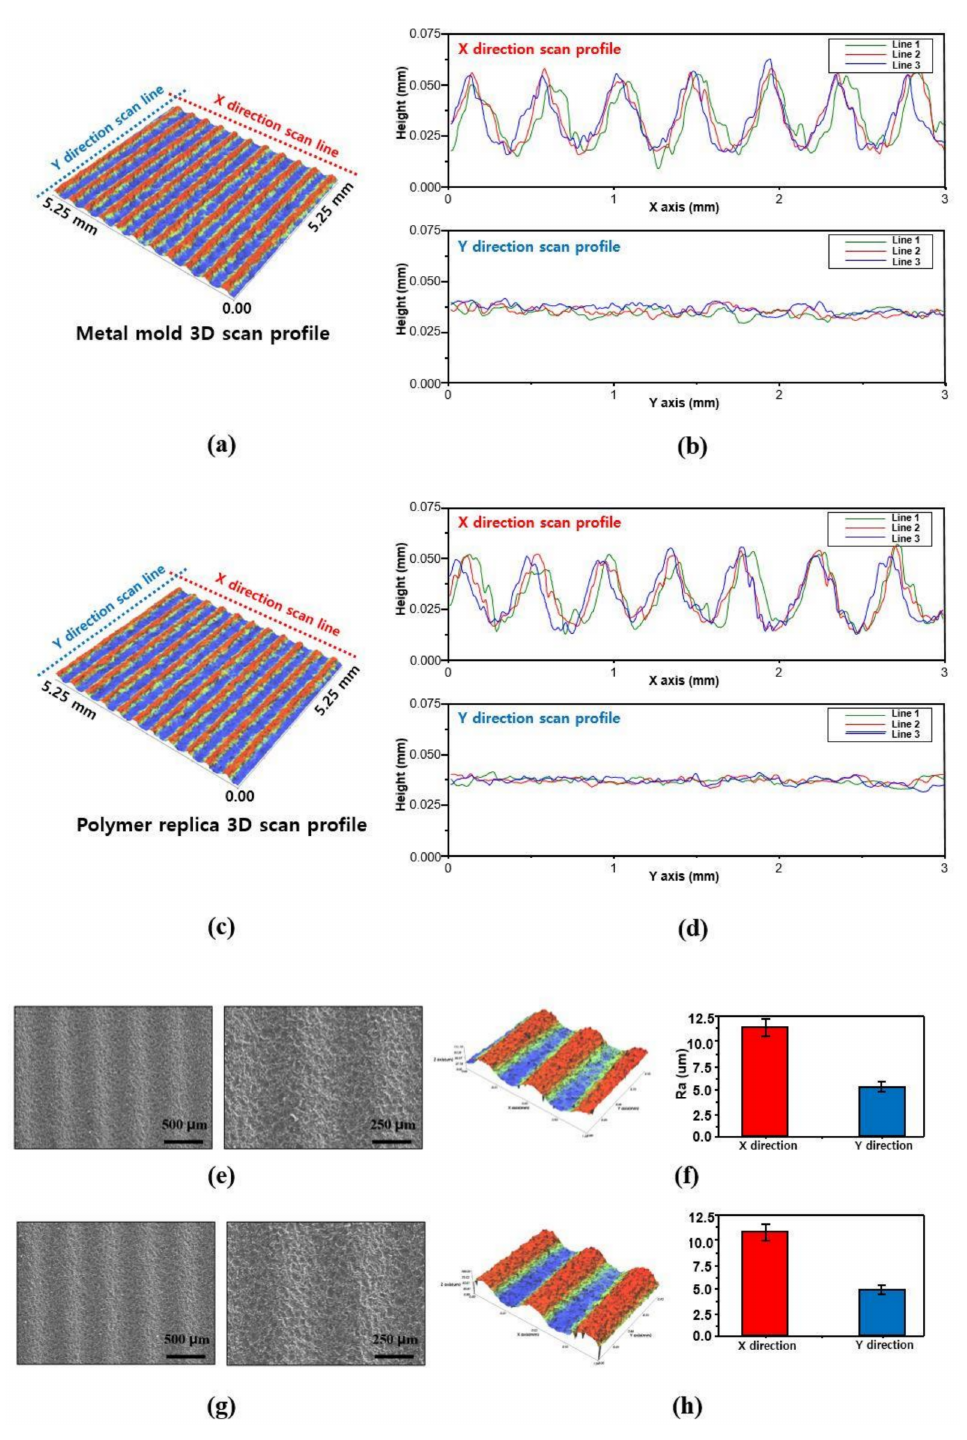
Figure 5. Fabrication of bio-inspired 3D master mold: ( a ) 3D image of metal mold surface after WEDM process taken by surface profile; ( b ) Line scan profiles of metal mold surface in X and Y directions; ( c ) 3D image of polymer replica surface after WEDM process taken by surface profiler; ( d ) Line scan profiles of polymer replica surface in X and Y directions; ( e ) SEM images of metal mold surface; ( f ) Enlarged 3D morphology image of metal mold surface and surface roughness averages ( R a ) measured in b. Error bars show the standard deviation of the three experiments; ( g ) SEM images of polymer replica surface; ( h ) Enlarged 3D morphology image of polymer replica surface and surface roughness averages ( R a ) measured in ( d ). Error bars show the standard deviation of the three